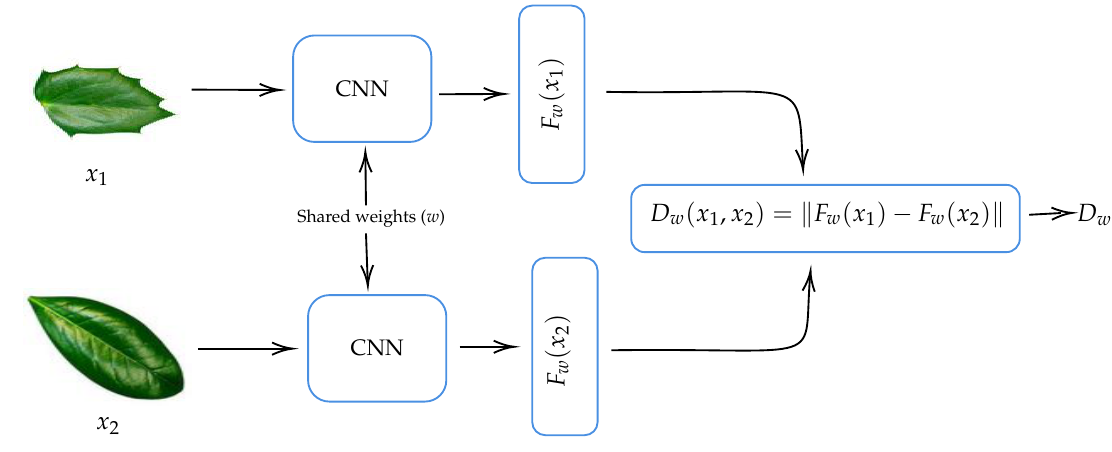
Figure 5. Diagram of the convolutional Siamese network